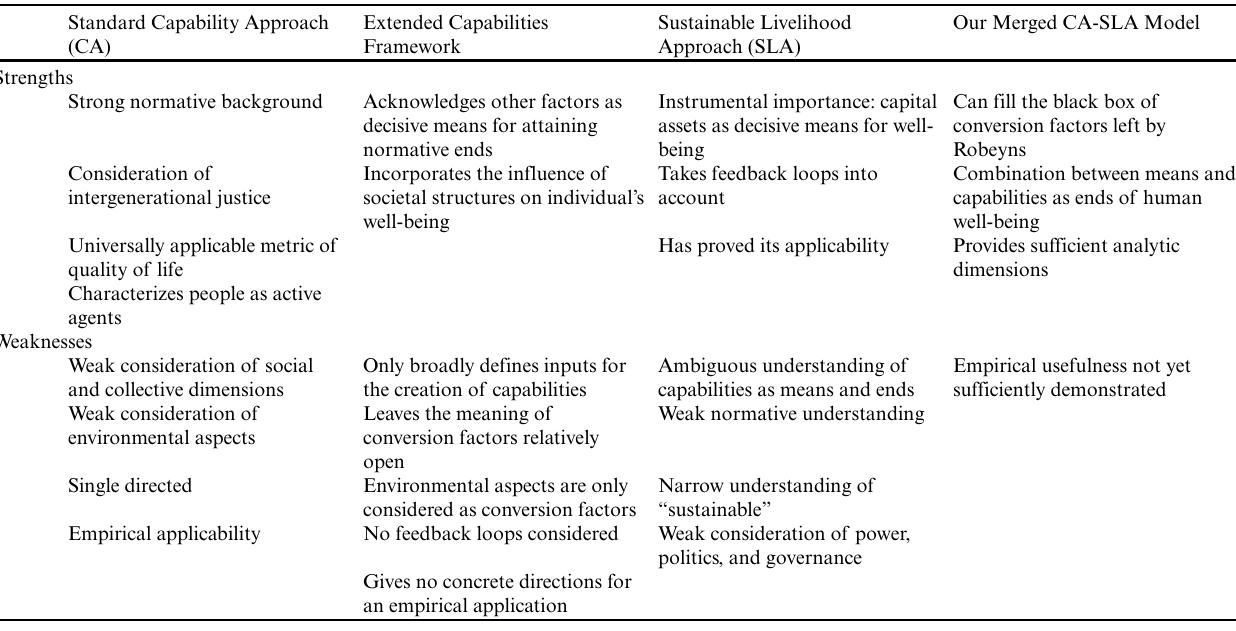
Table 1 . Overview of the strengths and weaknesses of the approaches